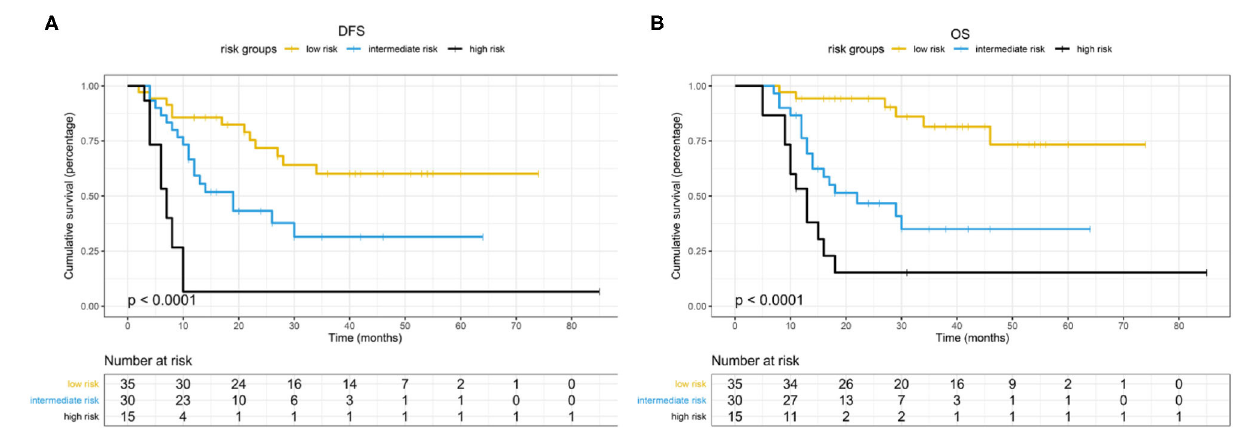
FIGURE 3 | Kaplan-Meier analyses of different risk groups of GI-PDNEN. (A) DFS. (B) OS.